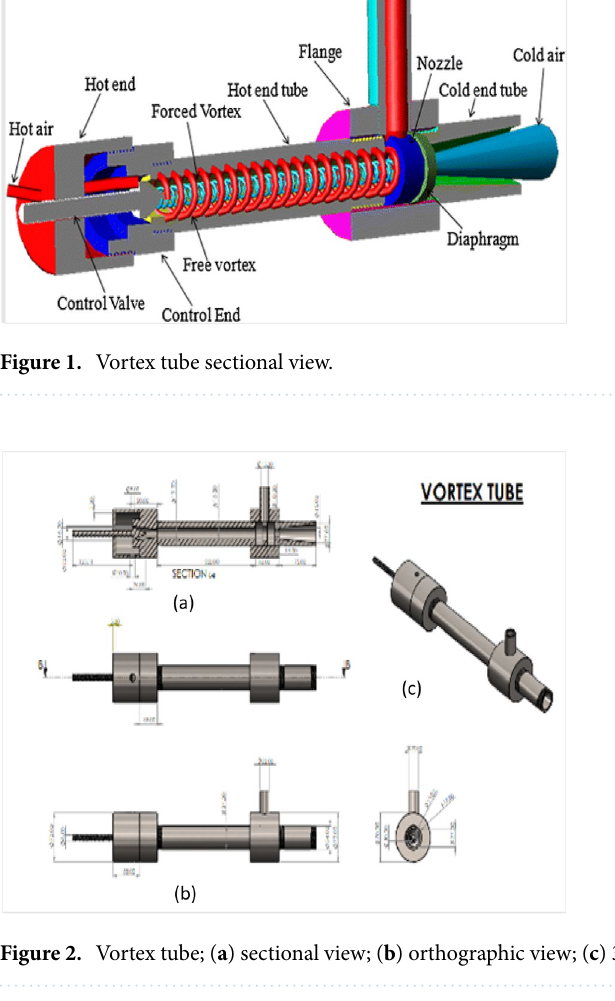
steel, PVC, CPVC, acrylic nylon, etc. Length/diameter of hot tubes (L/D) = 600/15 = 40. Nozzle diameter D n = 10 mm. Orifice diameter d c = 8 mm.